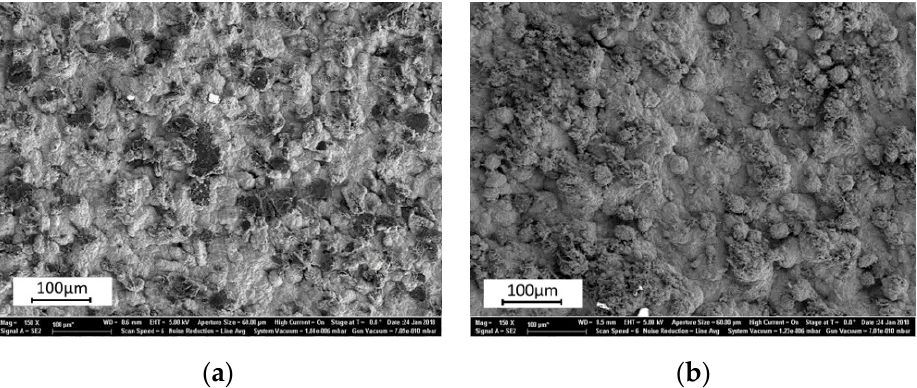
Figure 3. SEM images of surfaces of plating layers: ( a ) Fe–graphite composite plating layer; ( b ) Fe–multi-walled carbon nanotube (MWCNT) composite plating layer.